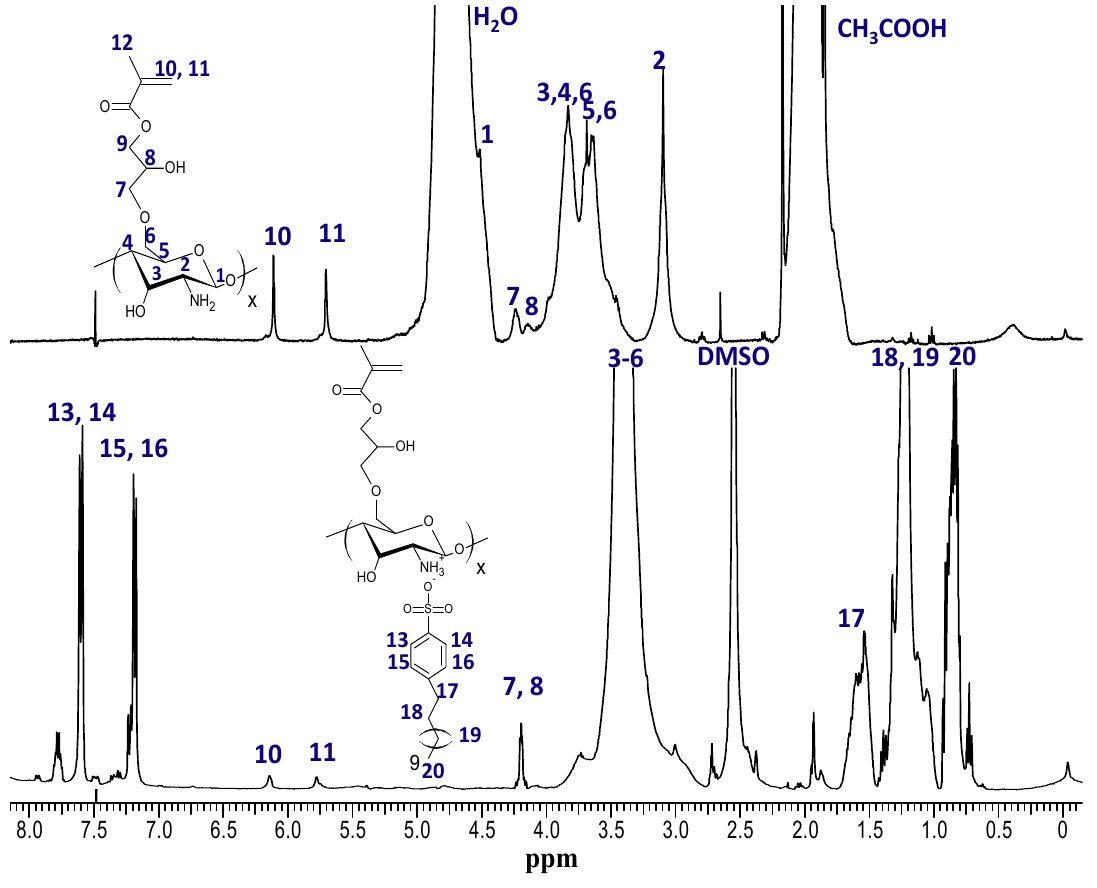
Figure 5. 1 H NMR of CTS ‐ g ‐ GMA ( Top ) and CTS ( Bottom ).